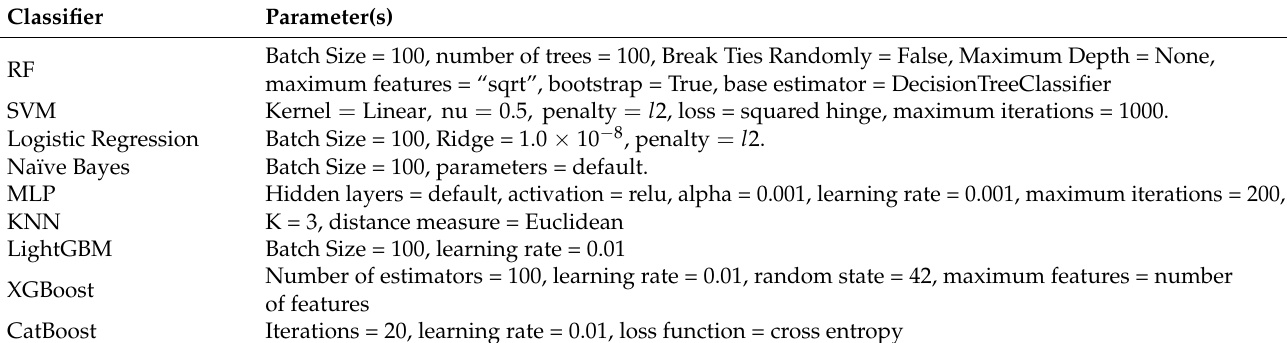
Table 2. Machine Learning models along with its parameter used in this